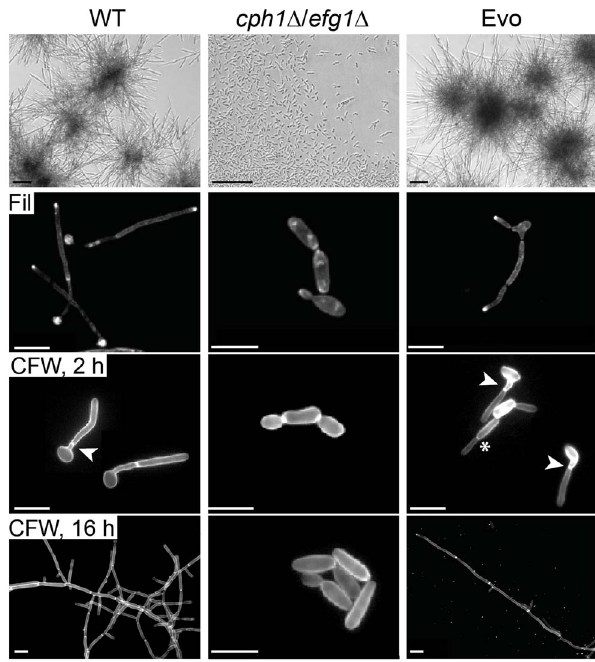
Fig. 1. Co-incubation with macrophages led to regained filamentation in the cph1 D / efg1 D strain. Morphology of wild type (WT), cph1 D / efg1 D and Evo strain after 18 h of incubation in DMEM + 10% FBS at 37 u C and 5% CO 2 demonstrate the re-appearance of filamentation in the Evo strain (scale bar: 100 m m, upper panel). All strains were grown for 4 h for filipin (Fil) staining, and for 2 h or 16 h for calcofluor white (CFW) staining on cover slips, and analyzed by fluorescence microscopy (scale bar: 10 m m, lower panels). Arrow heads highlight septa (true hyphae), while asterisks indicate constrictions